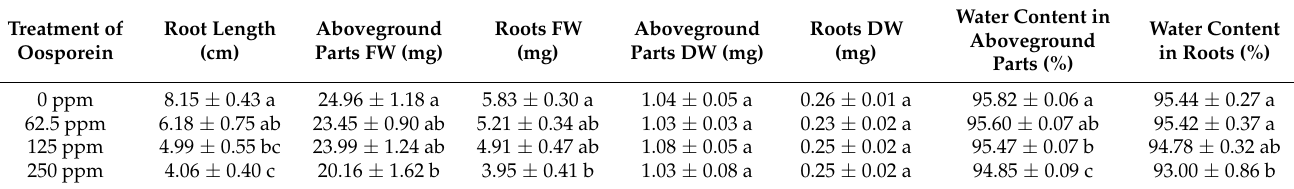
Table 2. Seedling growth of Lactuca sativa in growth inhibition test by oosporein.